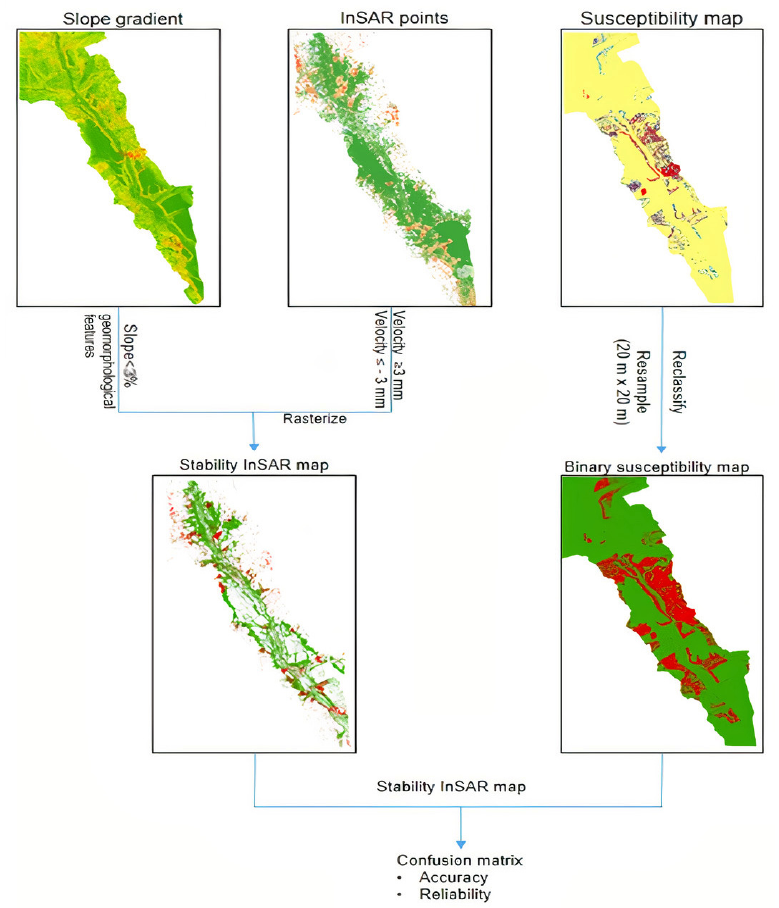
Figure 9. Workflow of InSAR validation in GIS.